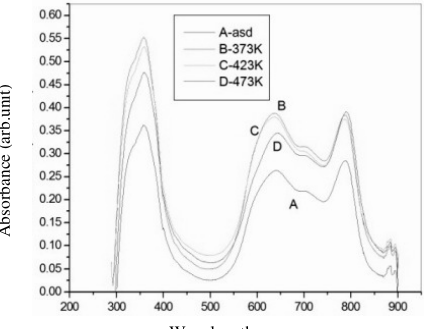
Figure 1. Plot of absorbance versus wavelength for F different vacuum annealing temperature